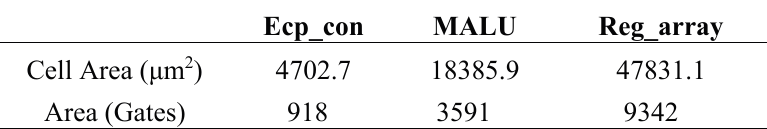
Table 1. Gate area of individual processor